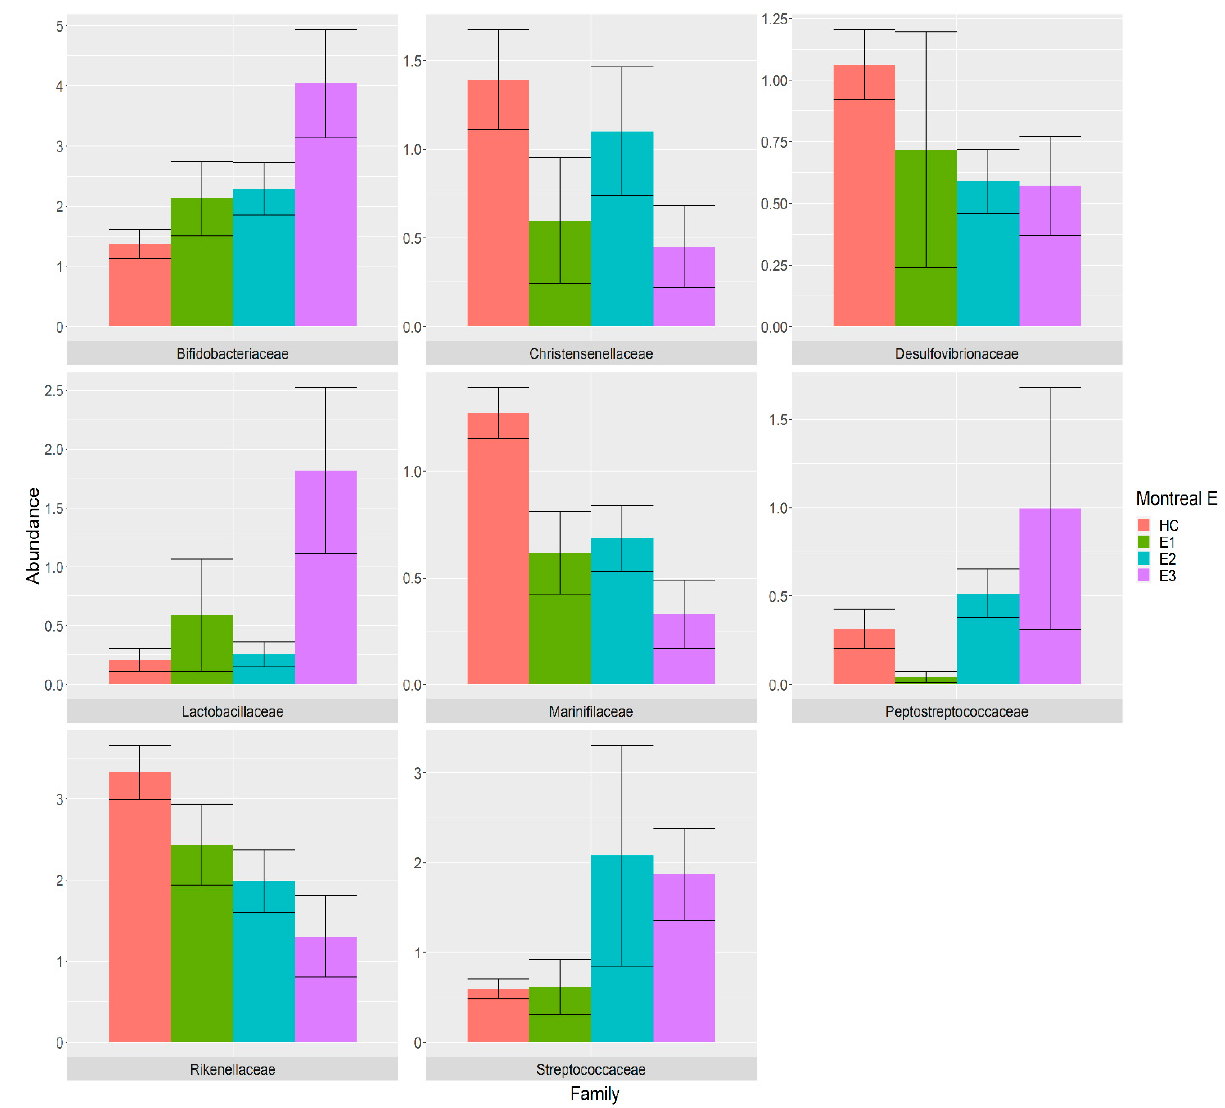
Figure 4. Bacterial families that were differentially abundant in samples from the E1 (green), E2 (cyan) and E3 (purple) patients compared with the HC (pink). The relative abundance is plotted in log10 on the y -axis.